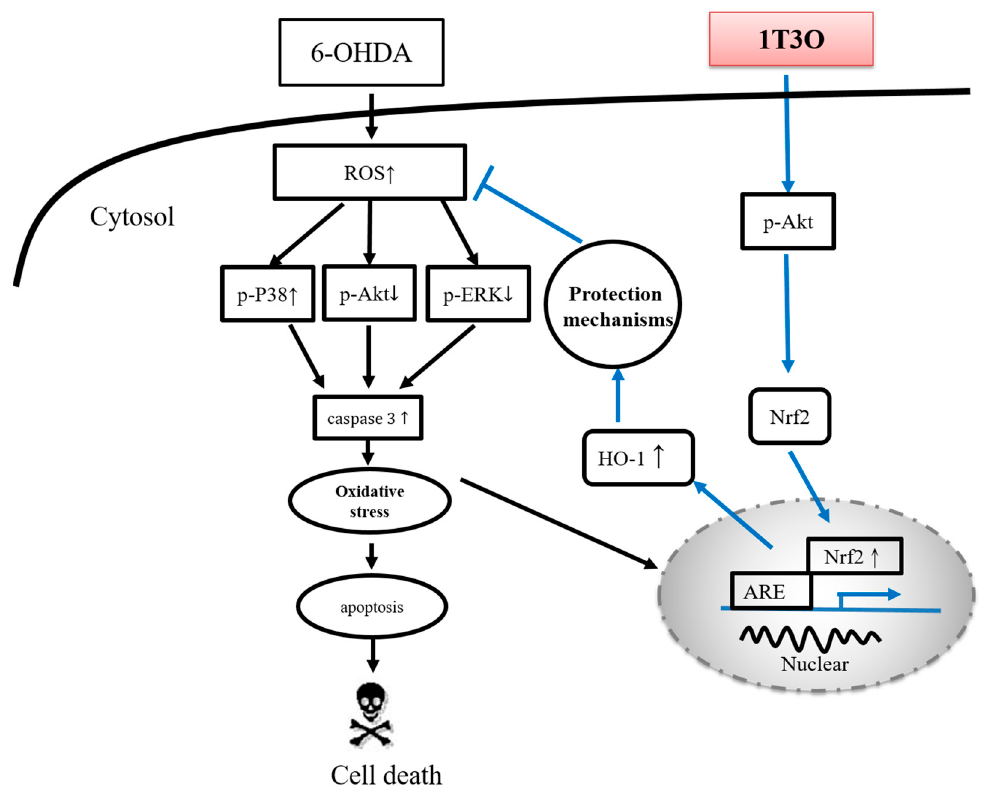
Figure 12. Neuroprotective mechanism of 1T3O. When cells are stimulated by 6-OHDA, a significant increase in ROS is observed. The transcription factor Nrf2 is activated, enters the nucleus, and binds to AREs to initiate transcription and induce the production of type-II enzymes, HO-1 and SOD, for cell protection. This is known as the endogenous antioxidant mechanism. 6-OHDA causes cellular apoptosis by decreasing the expression of phosphorylated Akt and ERK, and significantly activating p38 phosphorylation, resulting in caspase-3 activation. Administration of 1T3O activates the PI3K/Akt signaling pathway and causes the transcription factor Nrf2 to enter the nucleus and bind to AREs to induce an increase in both HO-1 expression and SOD activity to protect cells and counter oxidative stress. In comparison with the administration of 6-OHDA alone, the administration of 1T3O can better activate this signaling pathway to elicit its protective effects. In addition, 1T3O can inhibit the expression of caspase-3 via the phosphorylation of Akt and ERK, and can also attenuate the activation of p38 to prevent subsequent activation of caspase-3 expression to achieve its antiapoptotic and neuroprotective effects.